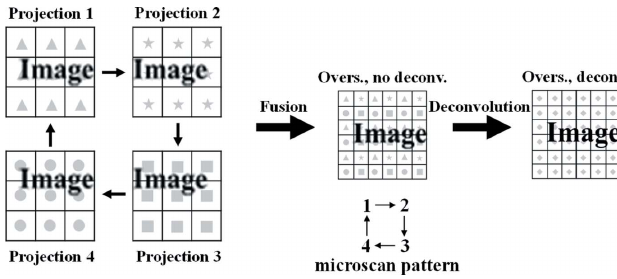
Figure 3 Representation of the 2 (cid:2) 2 micro-scanning